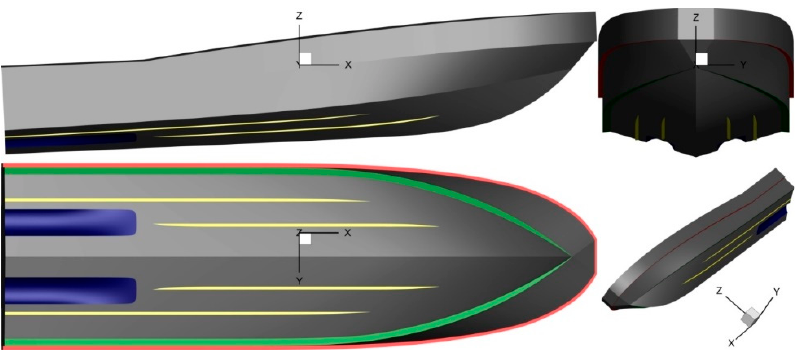
Figure 2. The boat geometry for V7 showing profile, front, bottom and isometric views, respectively.